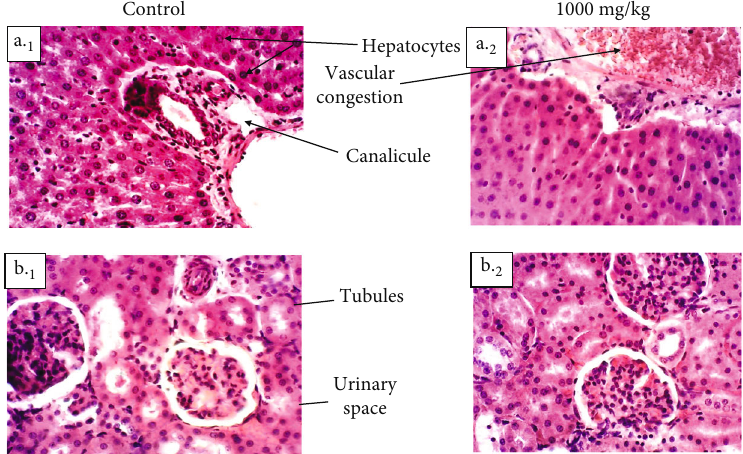
Values are mean ± standarddeviation of three replicates ( n = 3 ). In each sex, biochemical parameters of the treated groups are compared to the control (ANOVA followed to multiple comparison test of Dunnett). The values followed by the same superscript letters in the same column are not di ff erent